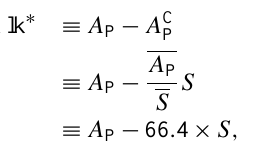
Figure 2 maps gridded global surface A T , salinity, Alk ∗ , and phosphate distributions and masks the regions that are lack- ing data in Fig. 1.